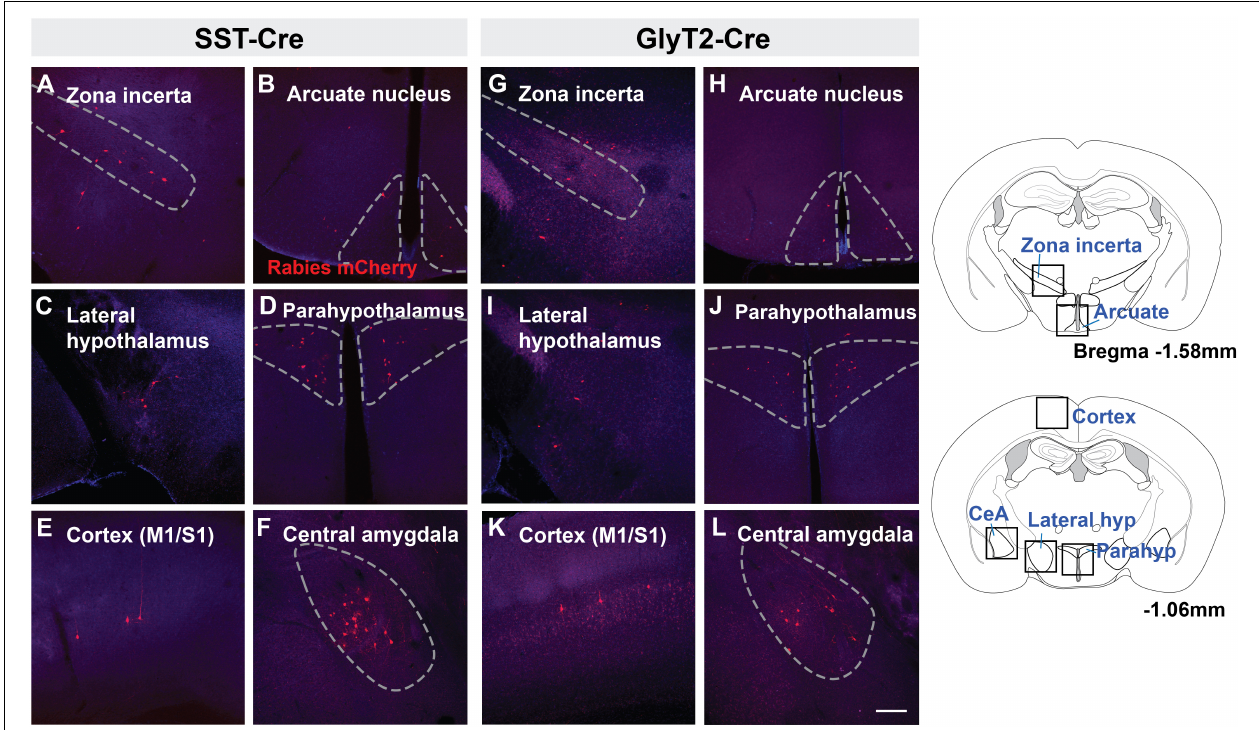
FIGURE 4 | Suprapontine afferent projections of SST + (A–F) and GlyT2 + (G–L) preBötC neurons extend to the zona incerta, arcuate nucleus, lateral hypothalamus, and paraventricular hypothalamus, as well as the central amygdala (CeA) and motor/sensory cortex (M1/S1). Boxes in schematic represent location of images shown. Scale bar = 200 µ